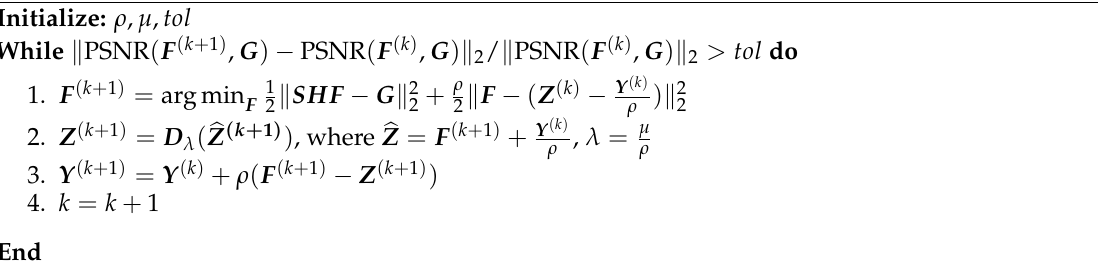
Algorithm 1 Super-resolution using the plug-and-play ADMM (alternating direction method of